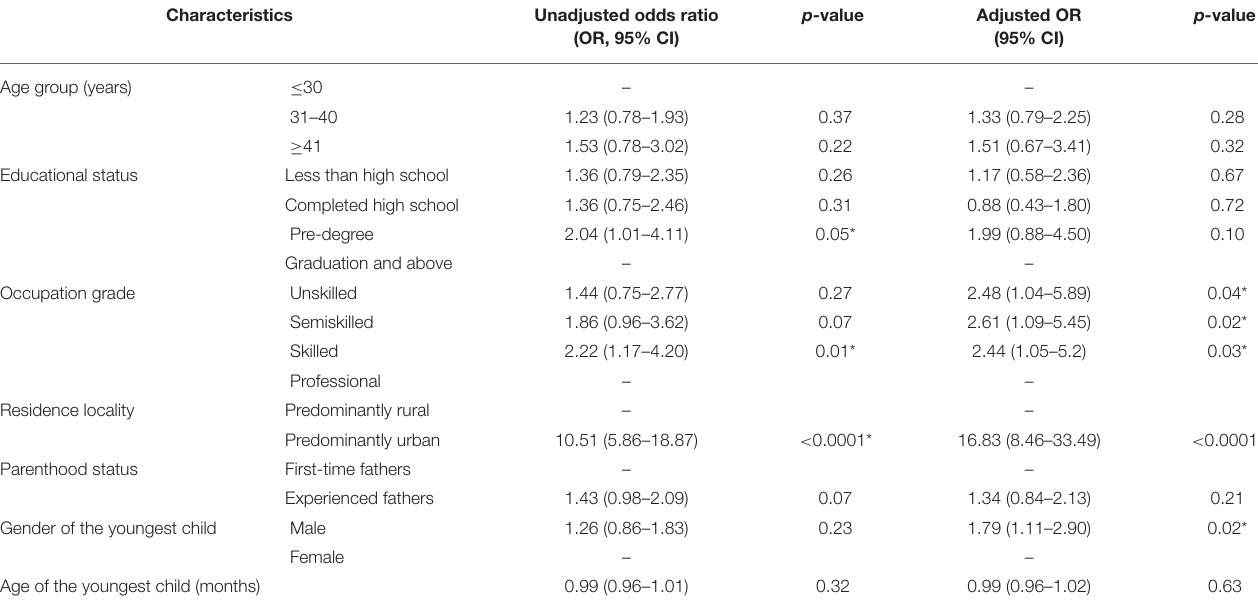
TABLE 6 | Multivariate analysis of covariates of poor involvement of study participants in IYCF ( N = 450).